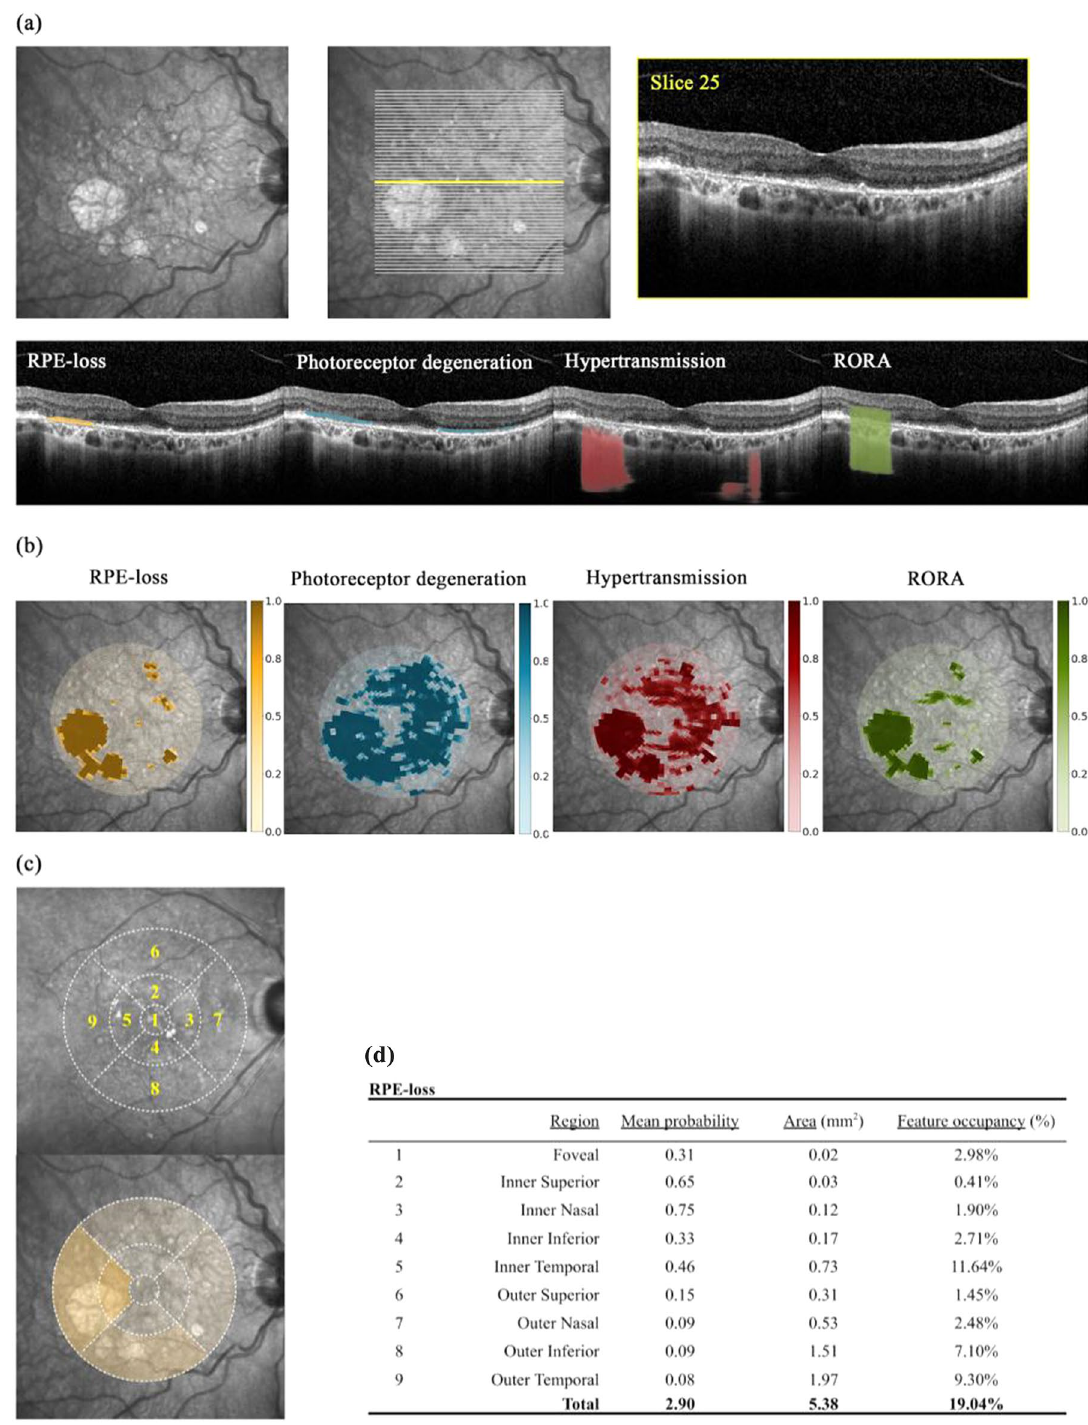
Figure 1. Image analysis workflow. ( a ) For each OCT volume, all b-scans were segmented for RPE-loss (orange), photoreceptor degeneration (blue), hypertransmission (red), and RPE and outer retinal atrophy (RORA; green). RORA is taken to be overlapping regions of the three former features i.e. co-occurrence as per a-scan. Exemplar segmentation of a single b-scan and its axis along en face fundus photograph. ( b ) Resultant feature probability maps from total volume segmentations collectively presented by projection onto en face fundus photograph. Colour legends represent target feature probability. Manual central foveal point annotation permitted interpolation of a given voxel’s localisation in relation to the fovea. ( c ) ETDRS regions were also considered wherein the macula is considered as a 6 mm diameter circle divided into 9 areas: central foveal area (1 mm diameter); 4 parafoveal (collectively span 3 mm diameter); and 4 perifoveal areas. ( d ) Here, the mean feature probability within each region is